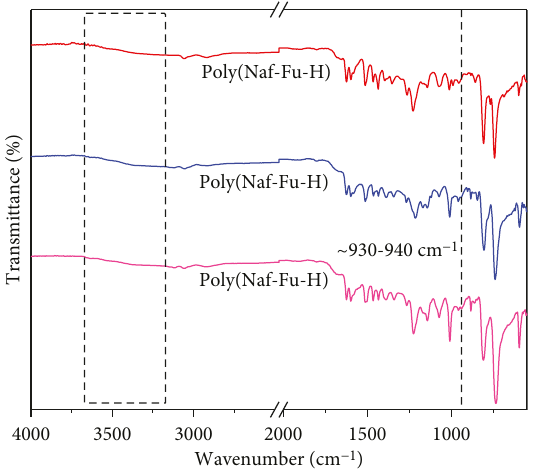
Figure 13: FTIR spectra of